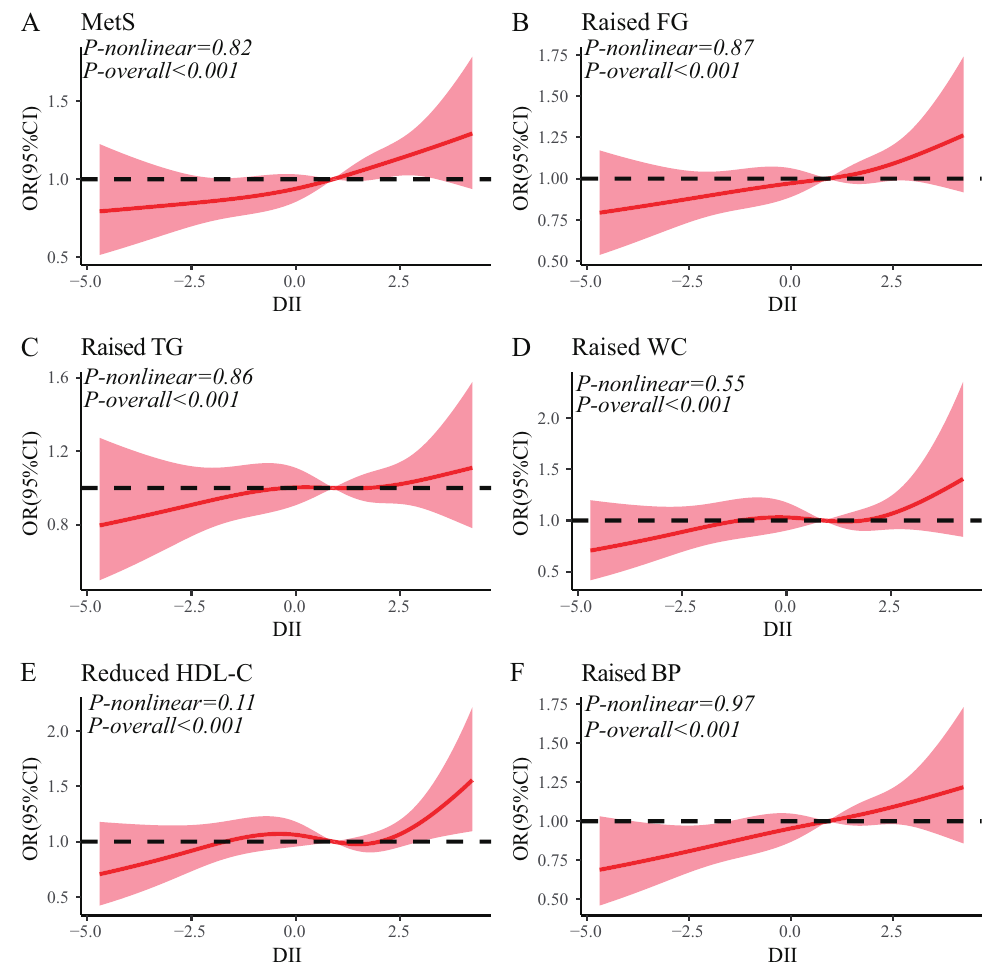
Figure 3. The restricted cubic spline for the associations of DII with MetS and its components. ( A ) Metabolic syndrome; ( B ) Raised FG; ( C ) Raused TG; ( D ) Raised WC; ( E ) Reduced HDL-C; ( F ) Raised BP. Knots were placed at the 5th, 35th, 65th, and 95th percentiles of the DII distribu- tion. Results were adjusted for age, gender, race, education, poverty–income ratio, smoking, alcohol consumption, and sedentary